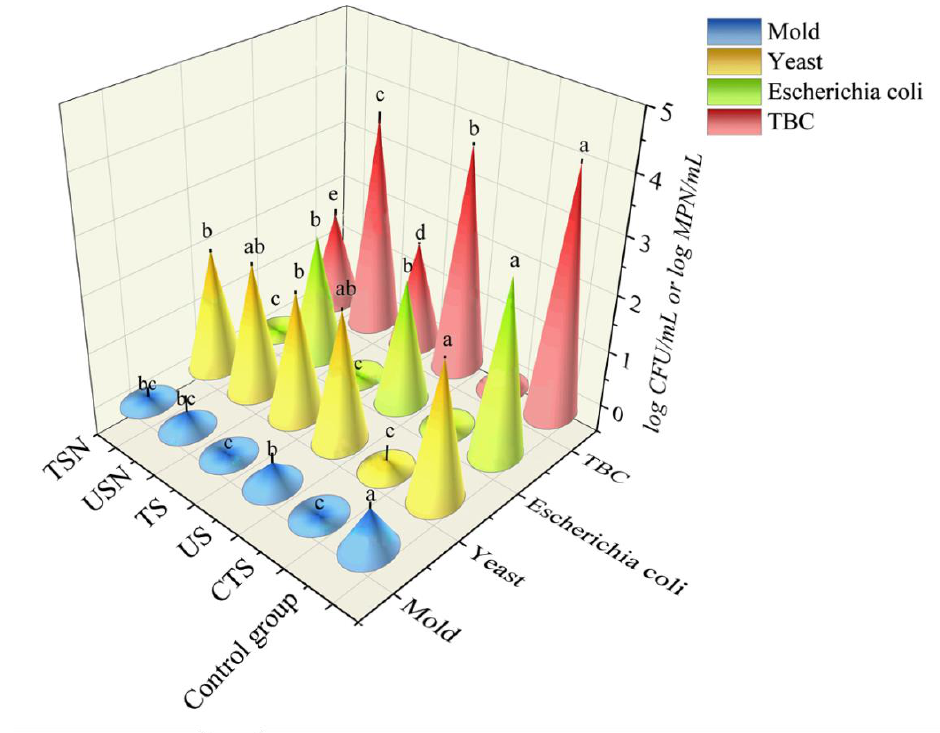
Figure 2. Lethal e ff ects of di ff erent sterilization treatments on the microorganisms in grape juice. The Escherichia coli results were expressed as log MPN / mL, and the other results were expressed as log Figure 2. Lethal effects of different sterilization treatments on the microorganisms in grape juice. The CFU / mL. Values with di ff erent letters a, b, c, d and e are significantly di ff erent ( p < 0.05) from each Escherichia coli results were expressed as log MPN/mL, and the other results were expressed as log CFU/mL.